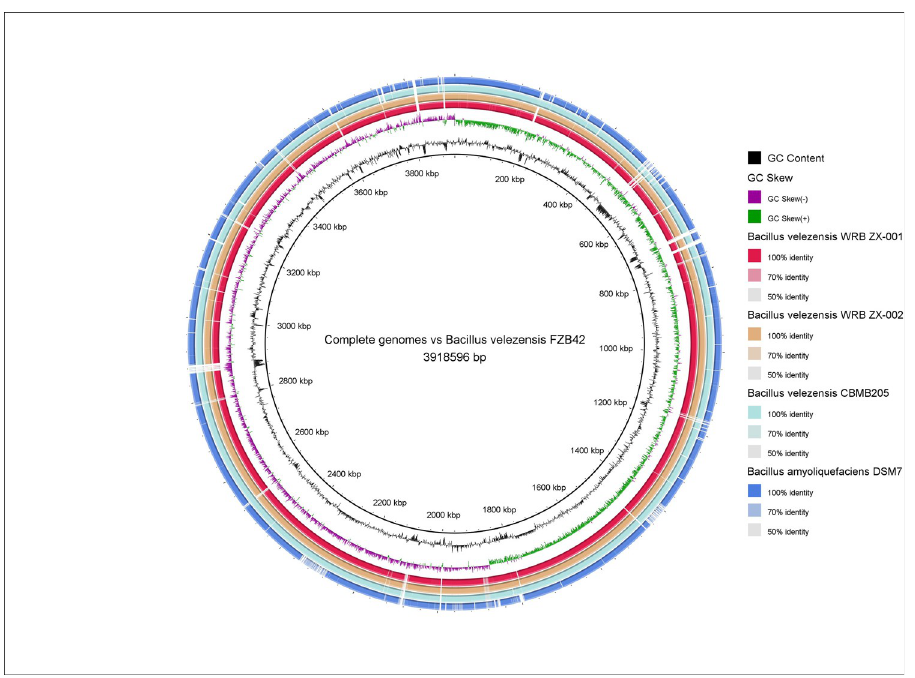
Fig 5. Genome comparison of Bacillus velezensis WRB-ZX-001 and WRB-ZX-002 against closely related Bacillus type strains. Bacillus velezensis FZB42 was used as the reference strain. The circular ring map was constructed by BLAST Ring Image Generator (BRIG, version 0.95). From inner to outer ring: 1) GC content; 2) Bacillus velezensis FZB42 nucleotide sequence; 3) GC Skew; 4) Bacillus velezensis WRB-ZX-001 nucleotide sequence; 5) Bacillus velezensis WRB-ZX-002 nucleotide sequence; 6) Bacillus velezensis CBMB205 nucleotide sequence; 7) Bacillus amyloliquefaciens DSM7 nucleotide sequence.